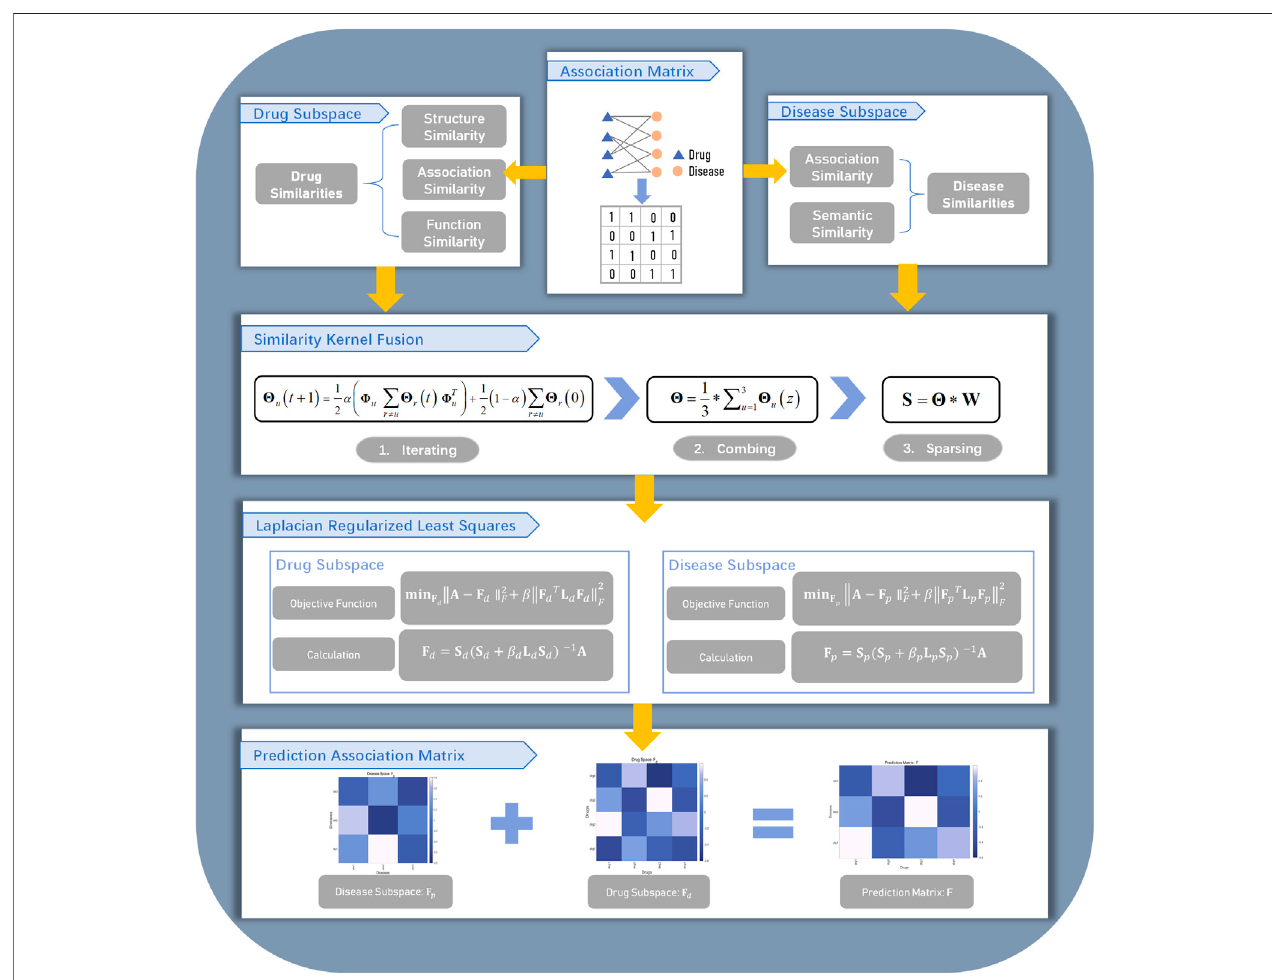
FIGURE 1 | Flowchart of DDA-SKF. The model DDA-SKF included three steps: (1) three drug similarity kernels and two disease similarity kernels were calculated; (2) similarity kernel fusion (SKF) algorithm was used to integrate these similarities into two comprehensive similarity kernels; (3) Laplacian regularized least squares (LapRLS) framework was used to build the prediction